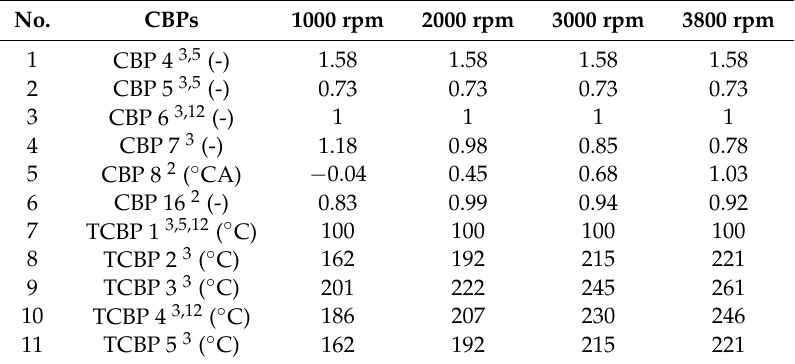
Table 7. Evaluated CBPs (Table 1) in calibration loop 1 at full-load operating points.